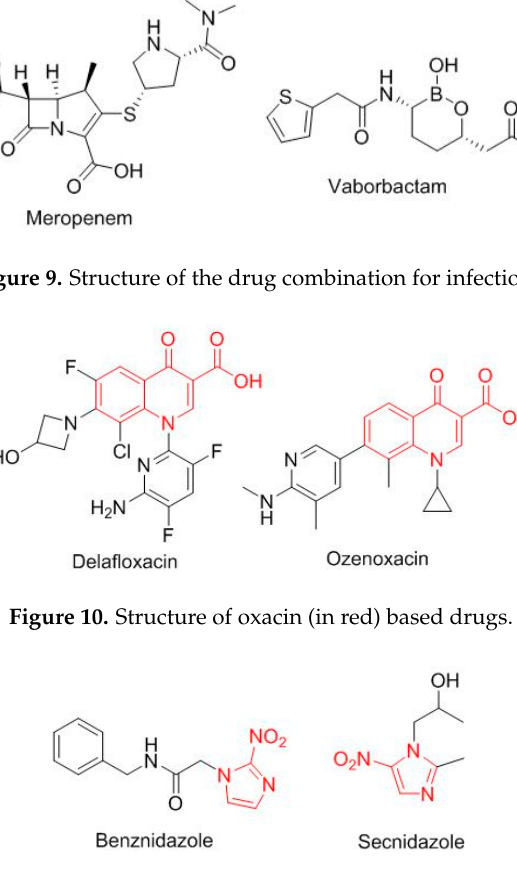
Figure 11. Structure of drugs derived of nitroimidazole (in red).